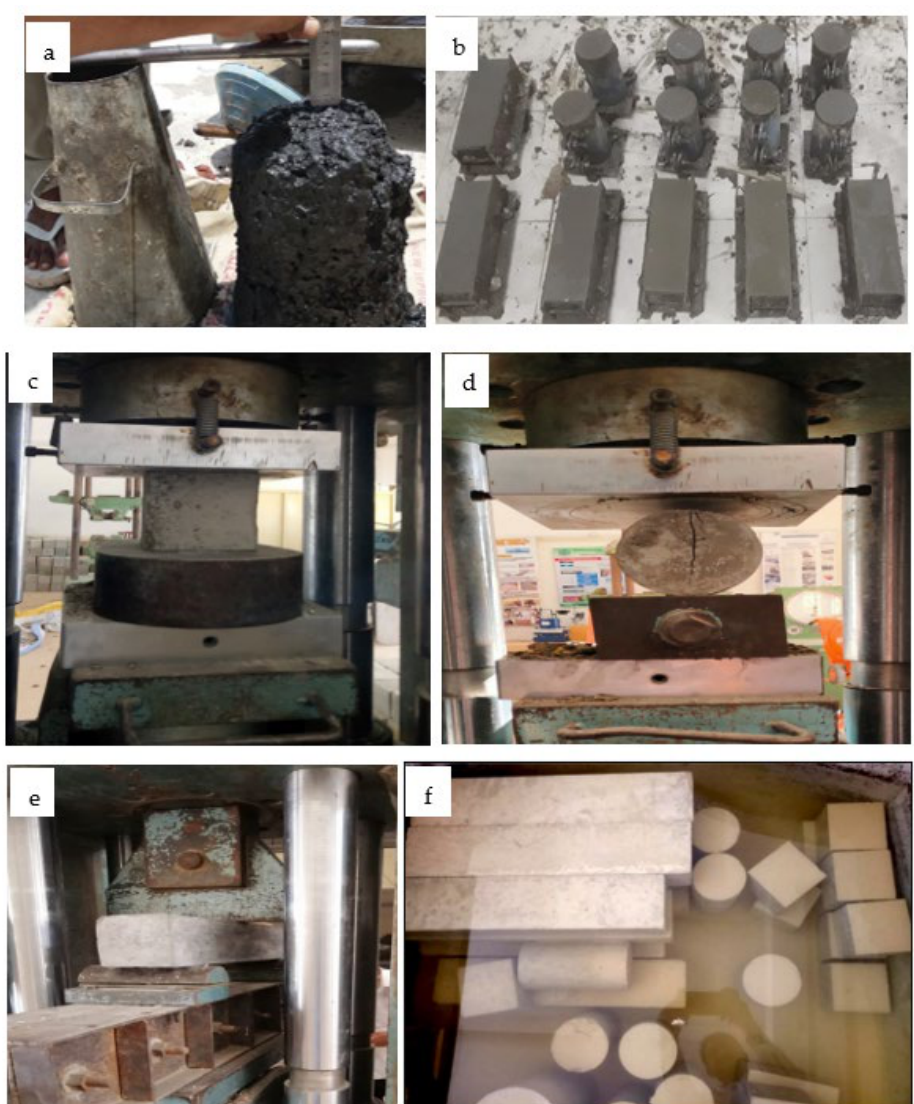
Figure 2. Experimental Program. ( a ) Slump test, ( b ) preparation of specimens after slump test, ( c ) compressive strength test, ( d ) splitting tensile strength test, ( e ) flexural strength, and ( f ) water curing tank.